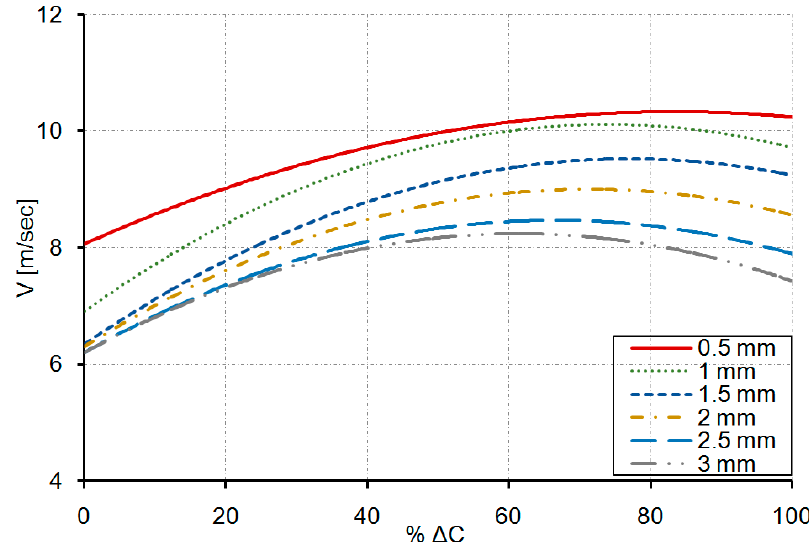
Figure 11. Velocity profile over the gap from button to top at leading edge. V: Velocity profile.